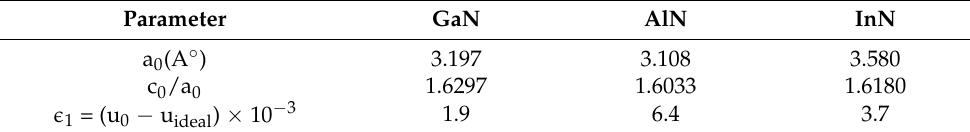
Table 2. Structural and polarization parameters of III-N wurtzite semiconductors [17]. Parameter